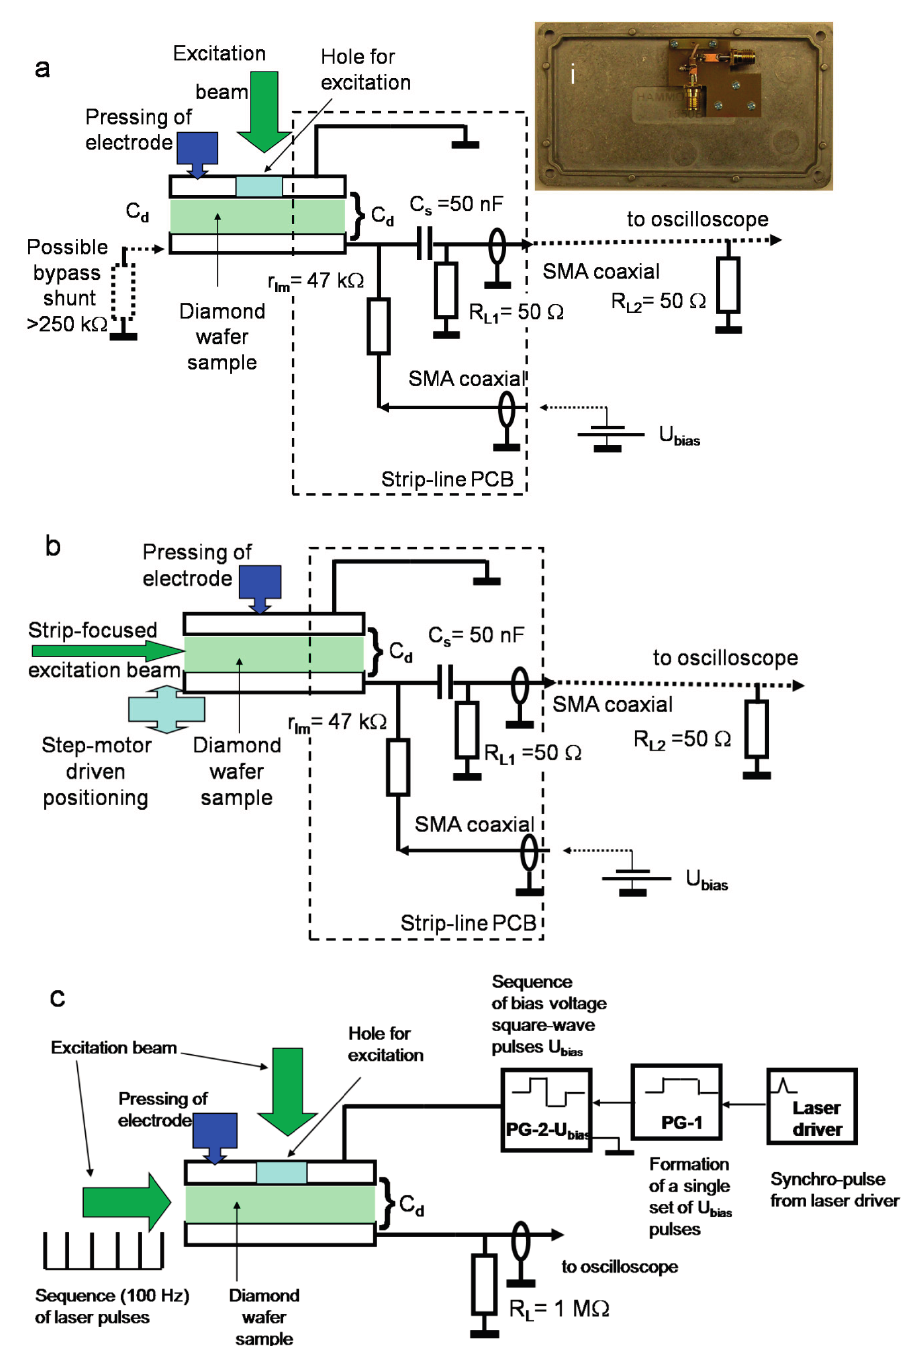
Figure 2. Schemes exploited for the recording of current transients using the parallel ( a ) and the perpendicular ( b ) profiling regimes are represented in Figures 2a,b, respectively. The DC bias voltage, varying bypass shunt has been applied within the circuit ( a ) for the investigation of relaxation features of the polarization effect. A picture of the PCB is also illustrated in the inset for Figure 2a. A scheme for examination of the origin and relaxation characteristics of the polarization effect by using pulsed applied voltage synchronized with a sequence of laser excitation pulses is shown in ( c ). Here PG denotes a pulse voltage